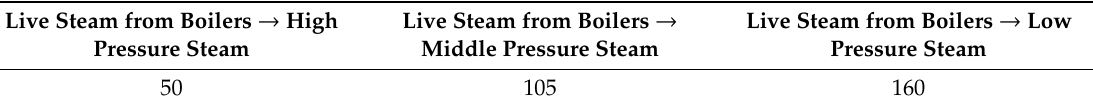
Table 6. Marginal backpressure electric energy production in the combined heat and power (CHP) unit, e bp , marg , CHP , s , in kWh per ton of expanding steam to the s-th pressure level. Live Steam from Boilers → High Live Steam from Boilers → Live Steam from Boilers → Low Pressure Steam Middle Pressure Steam Pressure